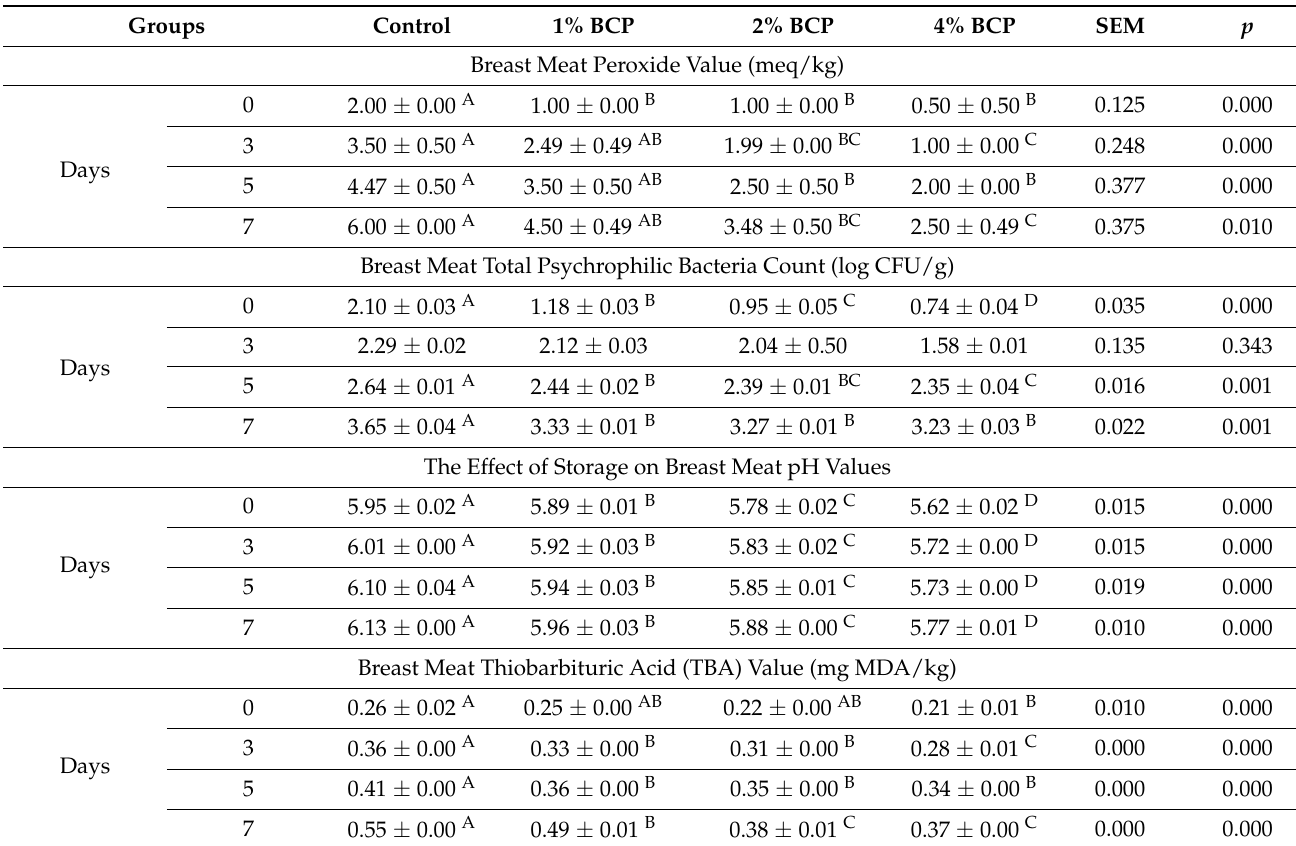
Table 6. The effect of the different levels of BCP supplementation on the breast meat peroxide value, total psychrophilic bacteria count, the effect of storage on breast meat pH values, and the breast meat thiobarbituric acid (TBA) value (mg MDA/kg).